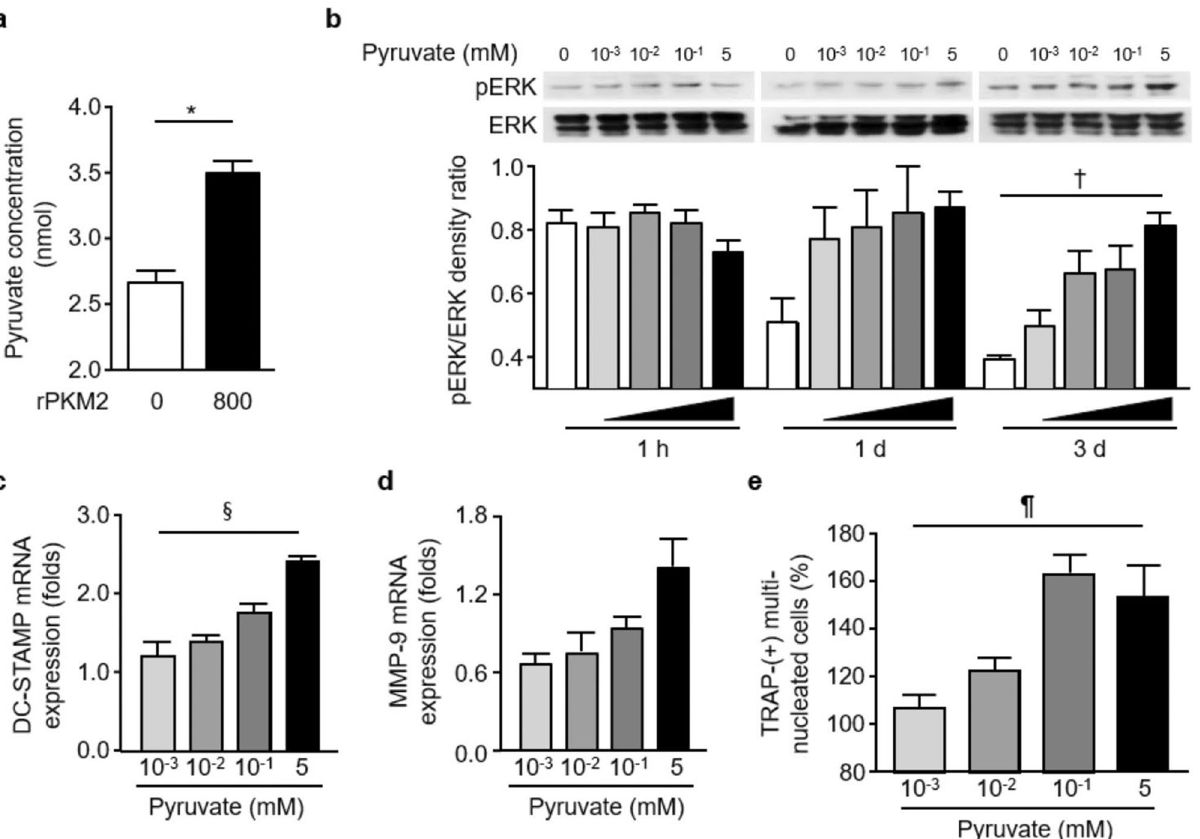
Figure 5. Effects of extracellular pyruvate on osteoclastogenesis through ERK signaling pathway. ( a ) recombinant PKM2 (rPKM2) catalyzed the conversion of phosphoenolpyruvate to pyruvate. Pyruvate increased additionally by an average 31.5% in 60 min with 800 ng/mL of rPKM2 (*p = 0.029 by the Mann–Whitney U test; n = 4). ( b ) With pyruvate treatment (0.001–5 mM), the level of phospho-ERK was significantly increased in RAW264.7 cells in a dose-dependent mode ( † p = 0.007 by Kruskal–Wallis test; n = 4). Uncropped images are shown in Supplementary Fig. 3c. ( c , d ) When RAW264.7 cells were treated with pyruvate, DC-STAMP and MMP-9 mRNA levels were increased ( § p = 0.005; n = 3). ( e ) Extracellular pyruvate dose-dependently augmented the formation of TRAP-positive multinucleated cells even without RANKL ( ¶ p = 0.0012). Data with error bars were expressed as mean ±